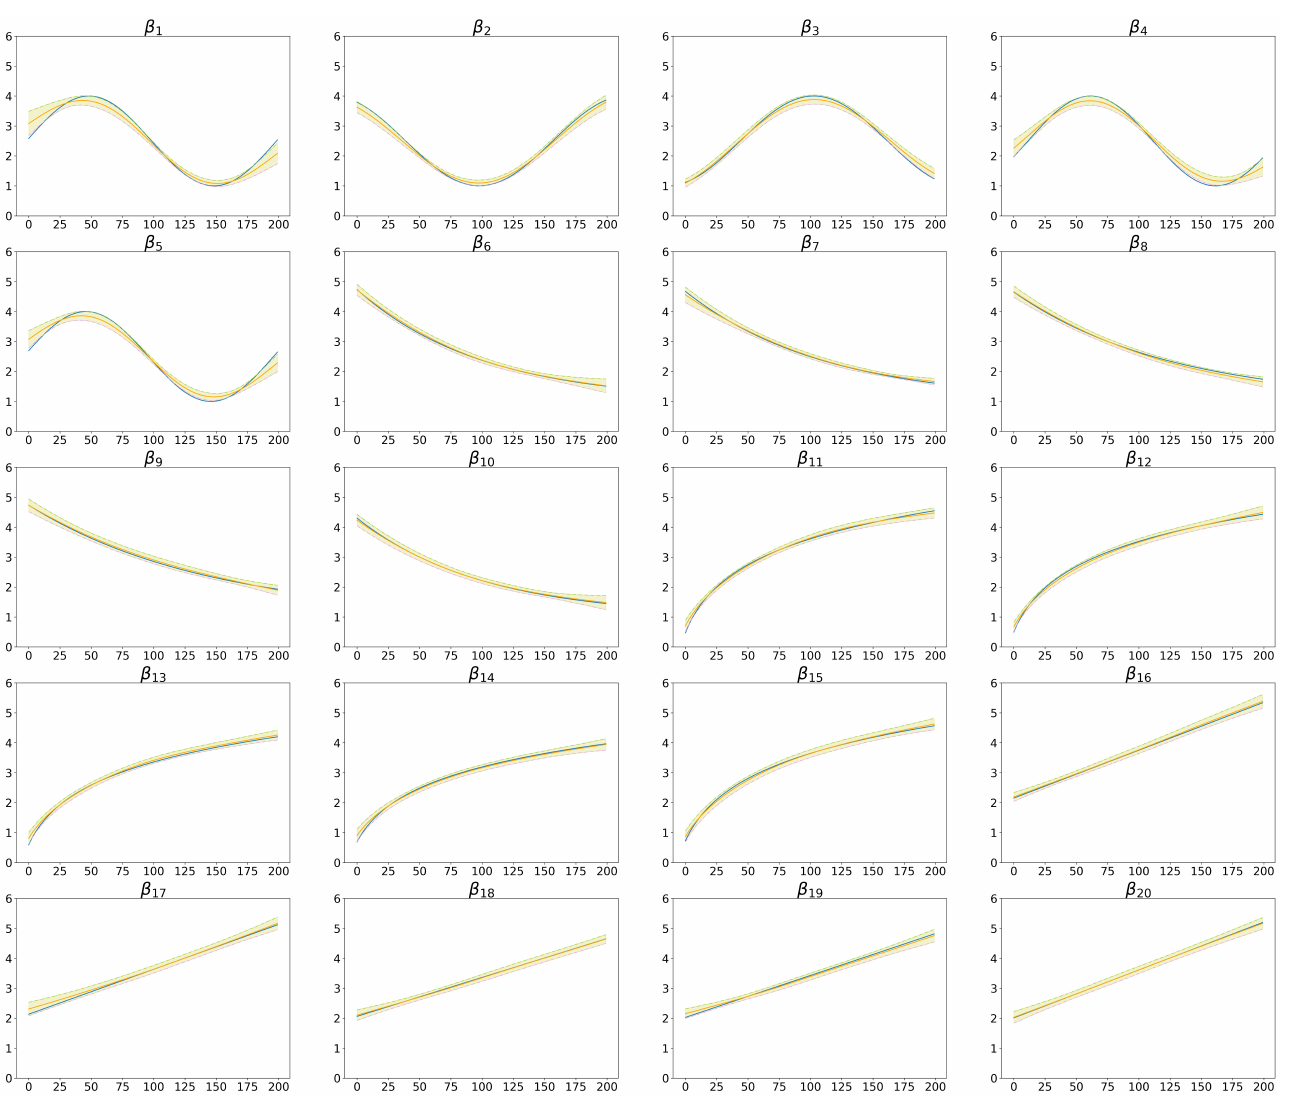
Figure A3. Estimated coefficients under Scenario 5 with N = 200, q = 20, and ρ = 0.3. The blue lines represent the true coefficients, the orange ones the coefficients estimated by New-Lasso, and the shadowed areas the 95% confidence intervals. The x -axis represents the subjects, and the y -axis represents the coefficient